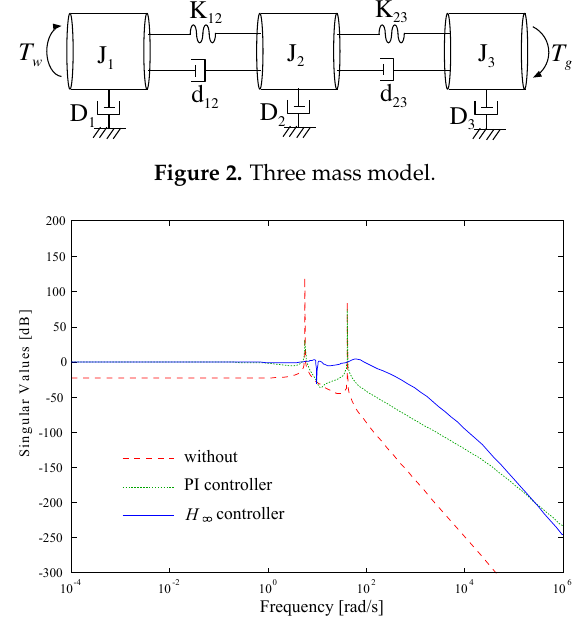
Figure 3. Frequency response of the shaft